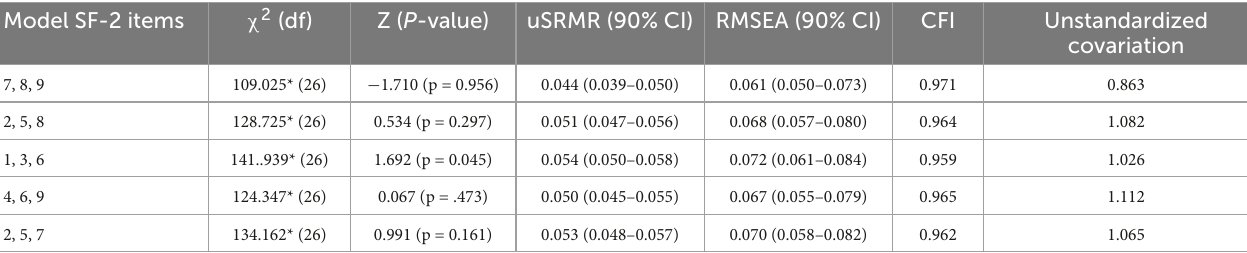
TABLE 5 Sensitivity analysis—fit indices of different random sets of items for specific factor 2. Model SF-2 items